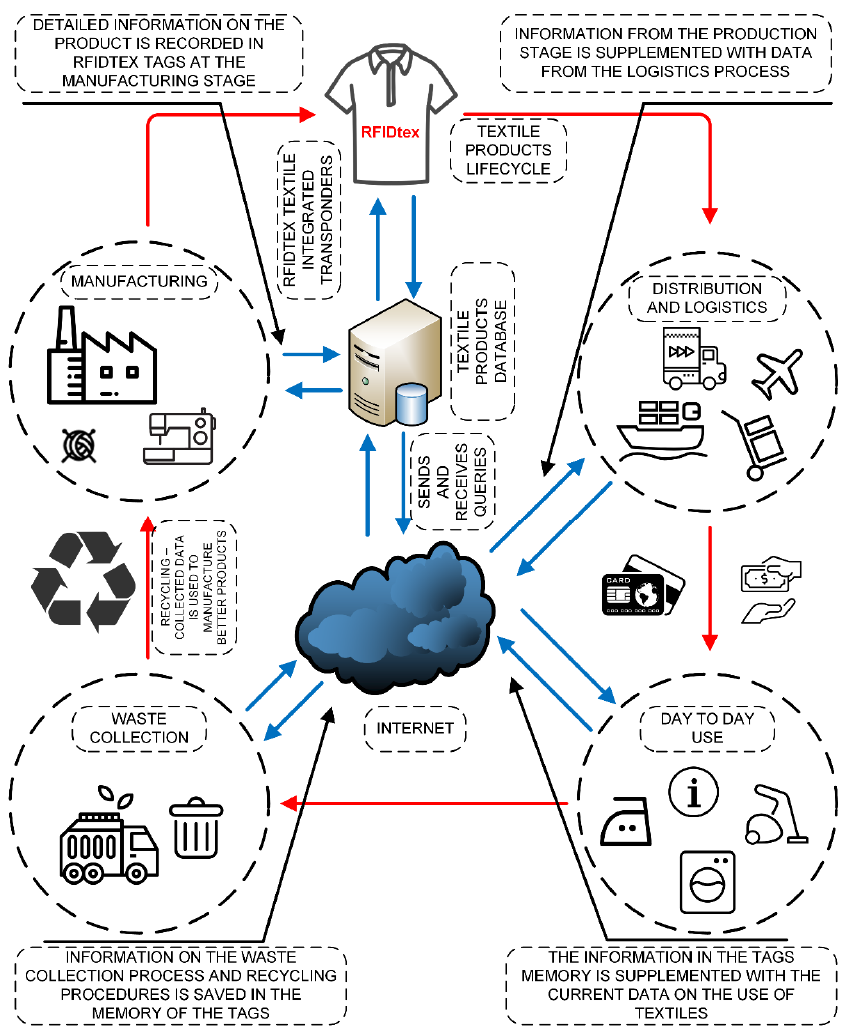
Figure 3. Simplified diagram of the RFIDtex equipped textile lifecycle and possibilities of RFID enabled home appliances in Internet of Textile Things (IoTT) applications.